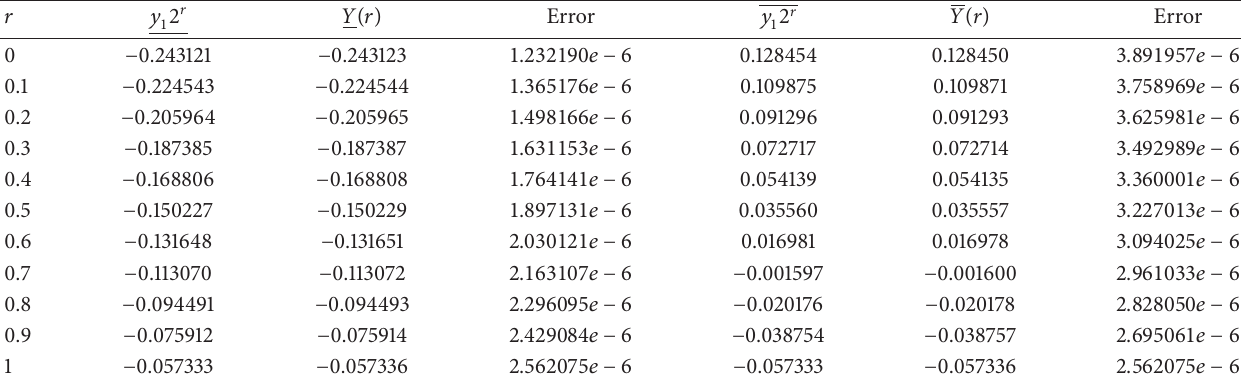
Table 6: The result of the proposed method for Example 63 with 𝛼 = 0.95 and 𝑚 = 12 .